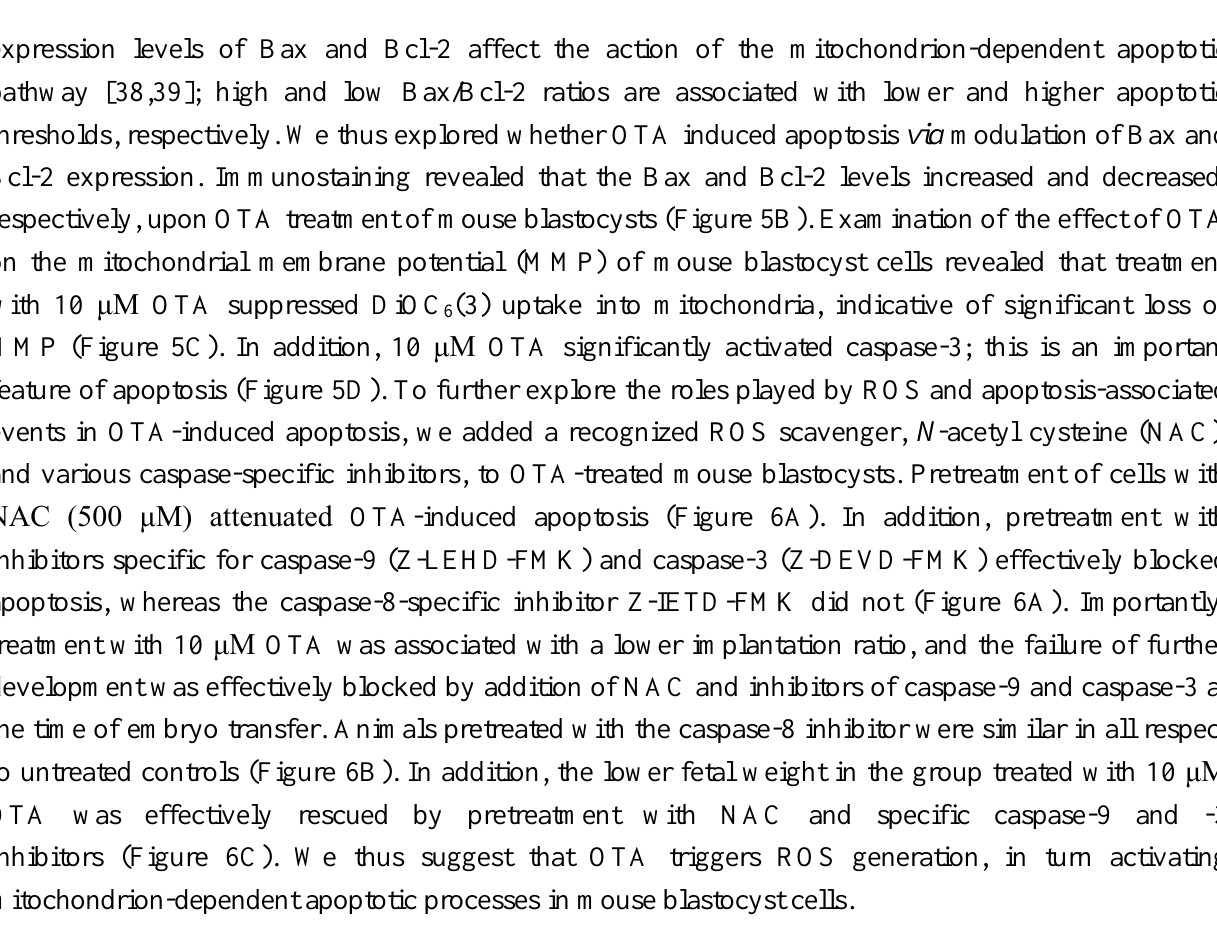
Figure 5. Effects of OTA on ROS generation and mitochondrion-dependent apoptotic processes in mouse blastocysts. Mouse blastocysts were treated with OTA (1, 5, or 10 μM), or left untreated, for 24 h. ( A ) ROS generation was detected by staining with a 20 μM solution of the DCF-DA fluorescent dye; ( B ) Bax and Bcl-2 expression levels were assessed via immunostaining using anti-Bax and anti-Bcl-2 antibodies, respectively. The protocol is described in Materials and Methods; ( C ) To determine changes in mitochondrial membrane potential, embryos were incubated with 40 nM DiOC6(3) at 37 °C for 1 h and examined under a fluorescence microscope; ( D ) Activation of caspase-3 was measured by immunostaining with anti-activated caspase-3 antibody for 3 h, followed by addition of a secondary antibody conjugated with peroxidase (1:100 dilution) for 1 h. Finally, 20 μL of DAB-substrate solution was added to each embryo, and incubation for 2 min at room temperature followed. Cells containing activated caspase-3 are shown in